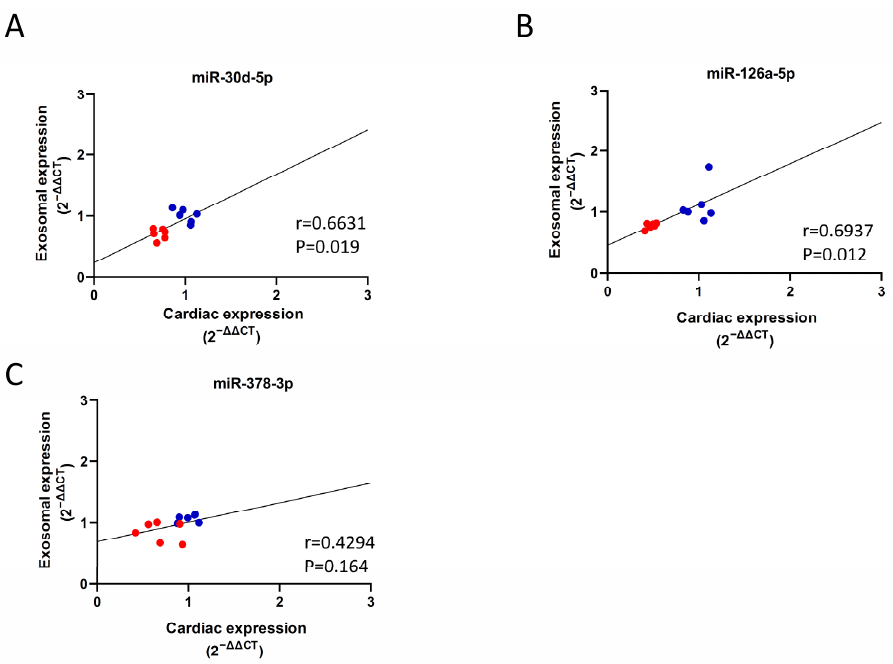
Figure 8. Correlation between exosomal expression and cardiac expression of miRNAs in diabetic HFpEF hearts. Pearson correlation coefficient (r) was used to determine the relationship between exosomal and cardiac expression in 12 total samples; control n = 6 (blue) and DM n = 6 (red). ( A ) miR-30d-5p shows a strong positive correlation. ( B ) miR-126a-5p shows a strong positive correlation. ( C ) miR-378-3p shows a moderate positive correlation.